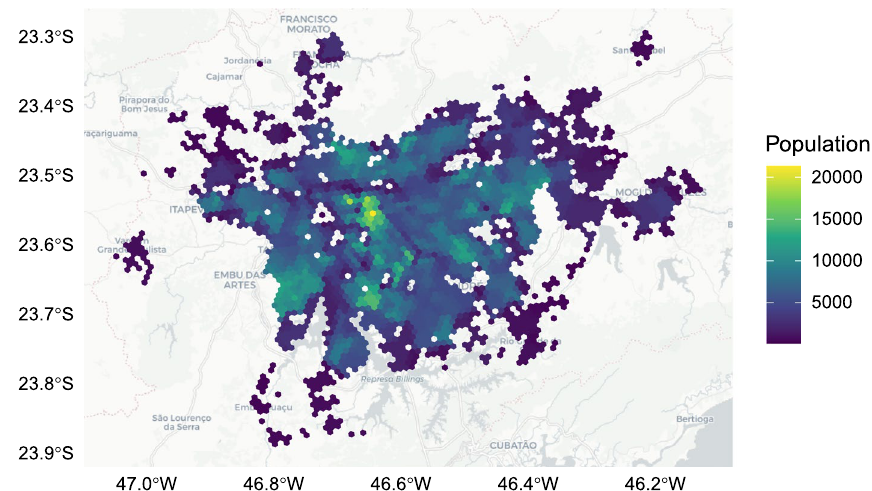
Fig. 1 Geographic distribution of all hexagonal cells in the Metropolitan Region of São Paulo for which daily isolation levels are available from the mobile analytics company InLoco/Incognia (Incognia 2020). Shows variation in populations across the Metropolitan Region of São